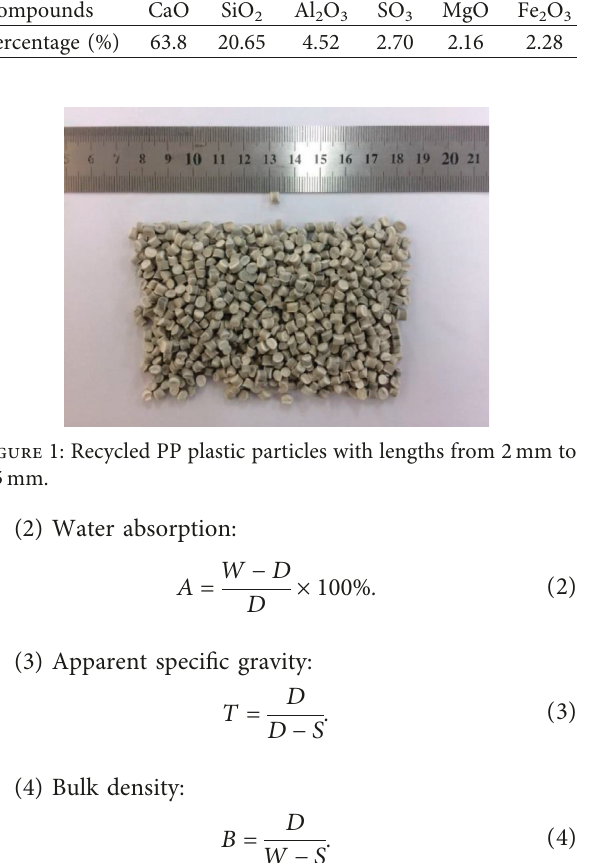
Table 1: The main chemical composition of the cement. Compounds